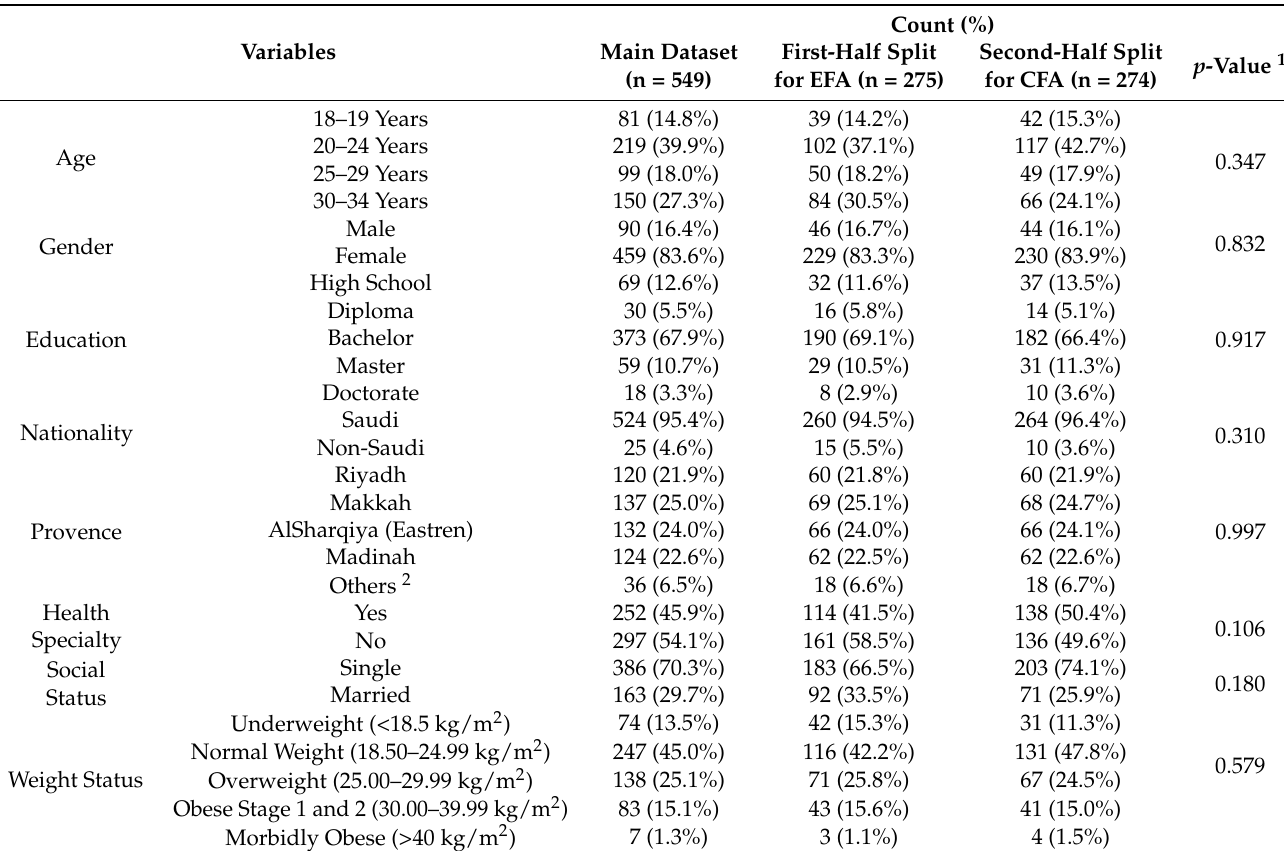
Table 1. Demographics characteristics of the participants.